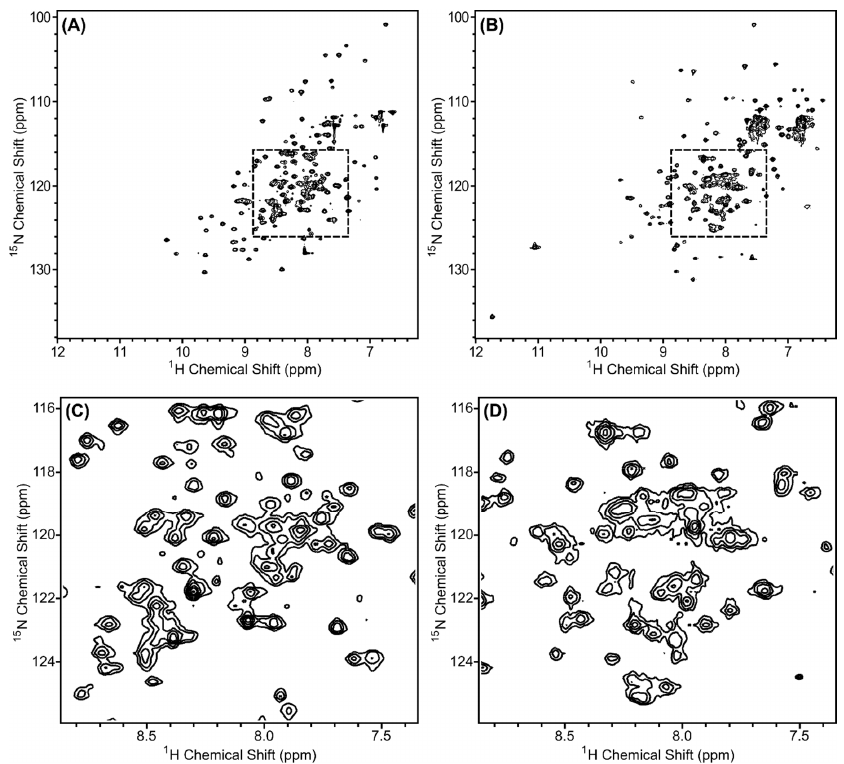
Figure 8. 1 H, 15 N-HSQC spectra of renatured ( A , C ) 15 N-Scc4:His 6 -Scc1 and ( B , D ) Scc4: 15 N-His 6 -Scc1 complexes. The regions shown in ( C , D ) are expanded from the dashed boxes shown in ( A , B ), respectively. All samples were 0.35 mM concentration and collected on a Bruker 500 MHz spectrometer with 64 scans. Biomolecules 2020 , 10 , x FOR PEER REVIEW 14 of 20